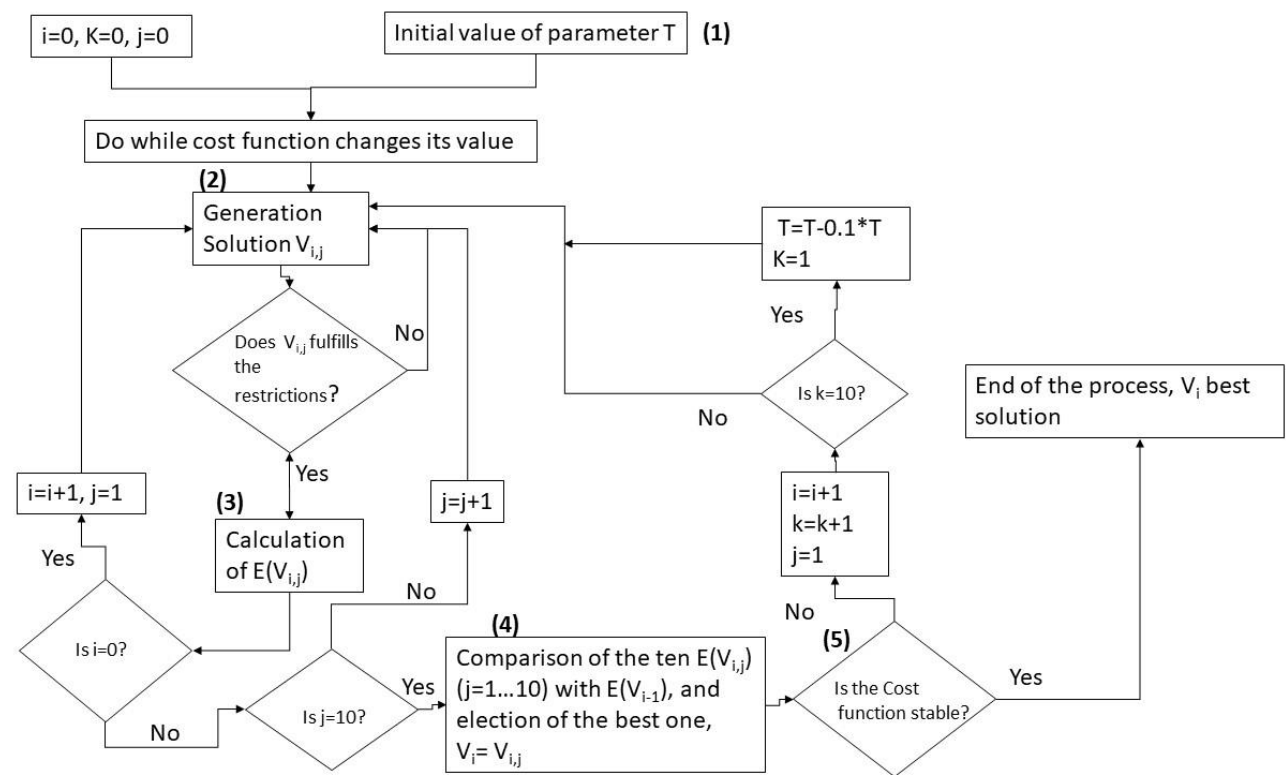
Figure 2. Optimisation process chart.